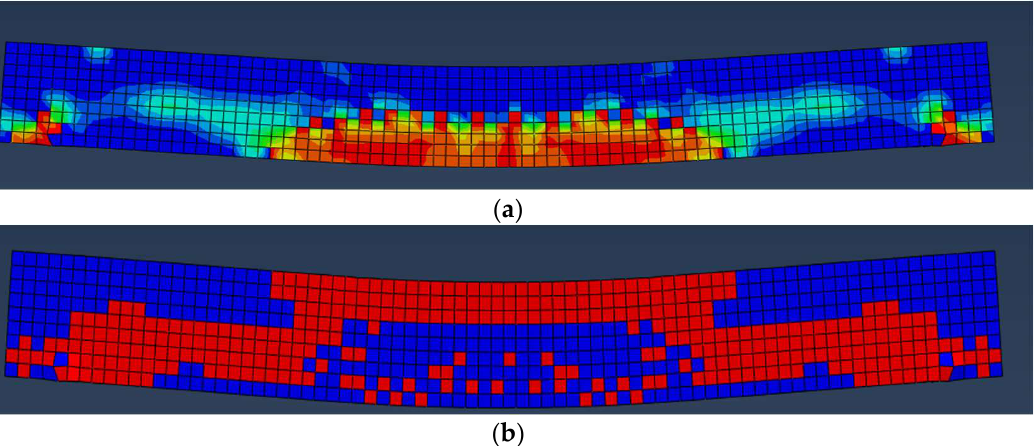
Figure 24. Analytical damage pattern of LWCM3. ( a ) Tensile damage of LWCM3; ( b ) Yield points of LWCM3.